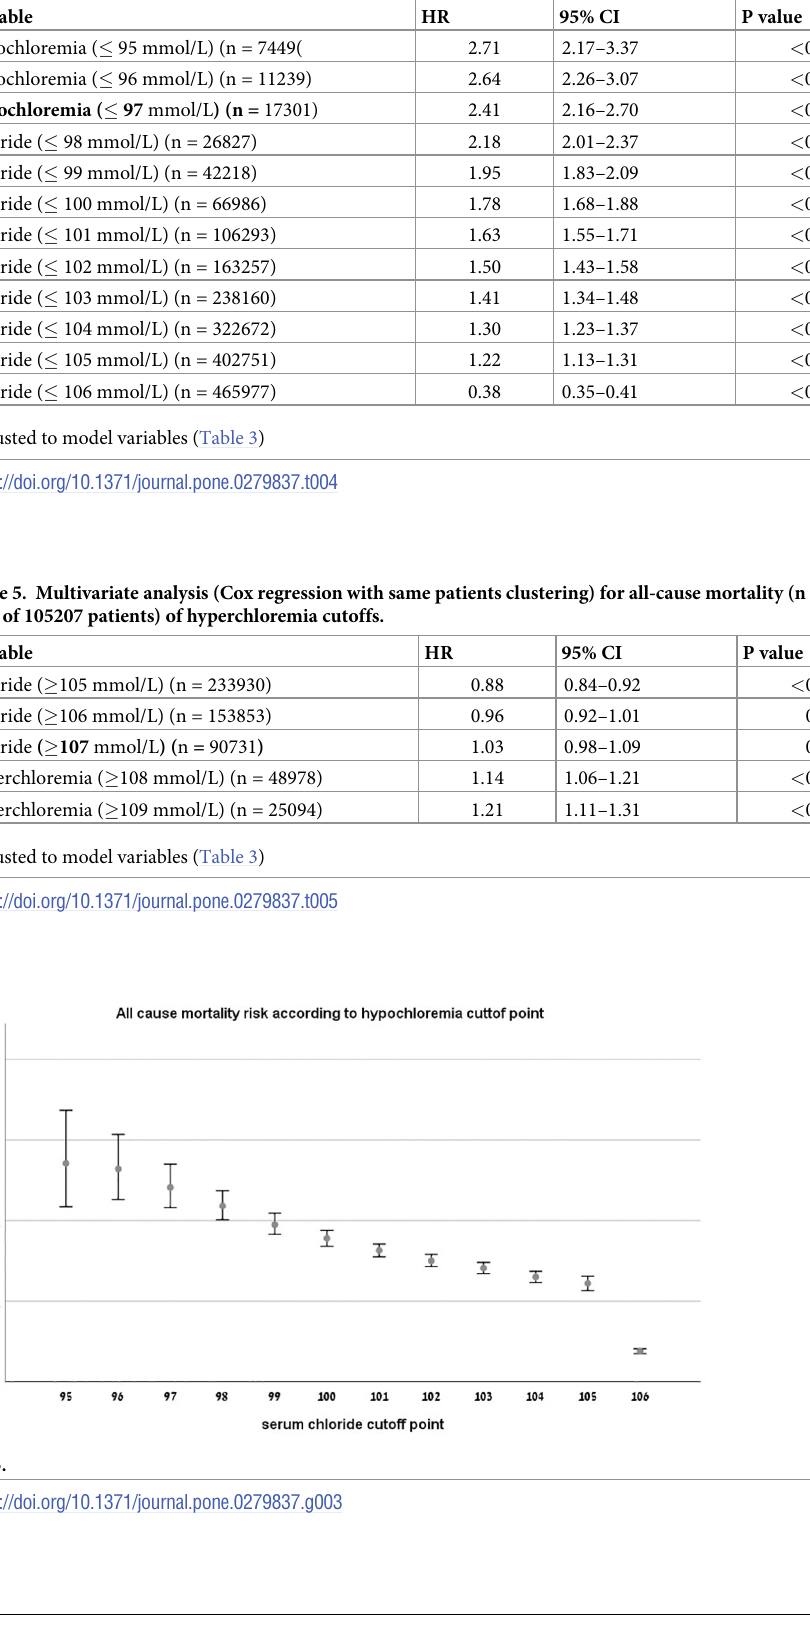
Table 4. Multivariate analysis (Cox regression with same patients clustering) for all-cause mortality risk of hypo- chloremia cutoffs (n = 556595 tests of 105207 patients).